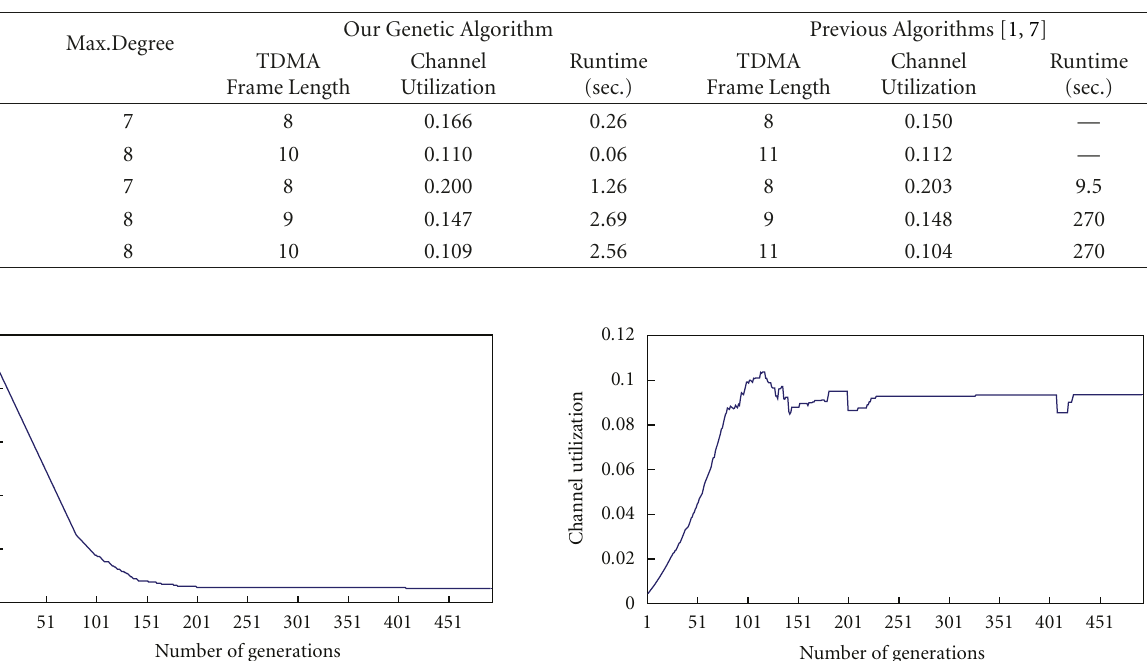
Table 2: Performance Comparison between Our Algorithm and the Previous Algorithms.